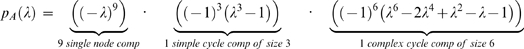
Persistence is controlled by the network's cyclical components of which there are two here (red patches); one simple component (3 patches, 3 links) and one complex component (6 patches, 9 links) formed by intersecting cycles.The other nine patches (blue, green) may be completely neglected since they do not belong to any cycle and therefore play no role in determining persistence. The characteristic equation for the eigenvalues of the adjacency matrix  is (see Text S2 for details):The spectral radius () of the adjacency matrix  is the root of largest magnitude of the polynomial arising from the complex cyclical component:  (giving ). Thus the complex component exclusively controls persistence in that it alone determines the spectral radius of the adjacency matrix . The new characteristic equation after removal of this link is: